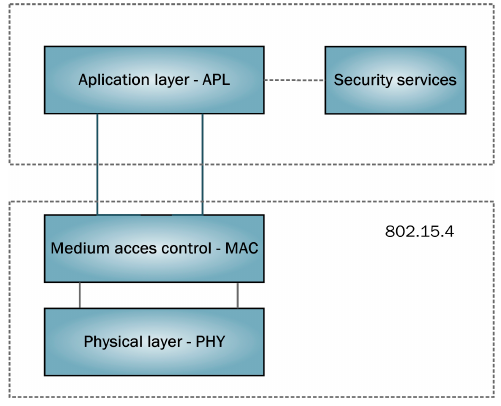
Figure 2. Layer model.